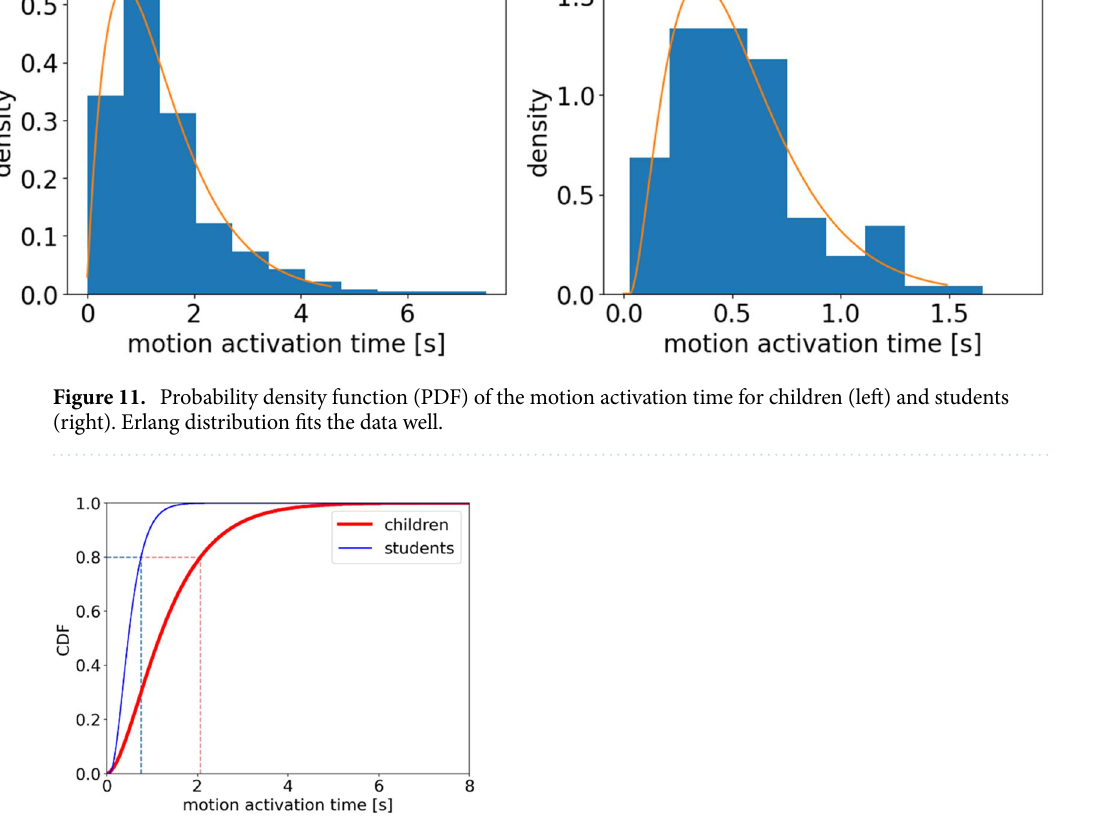
Figure 12. Cumulative distribution function of motion activation time of children (red thick line) and students (blue fine